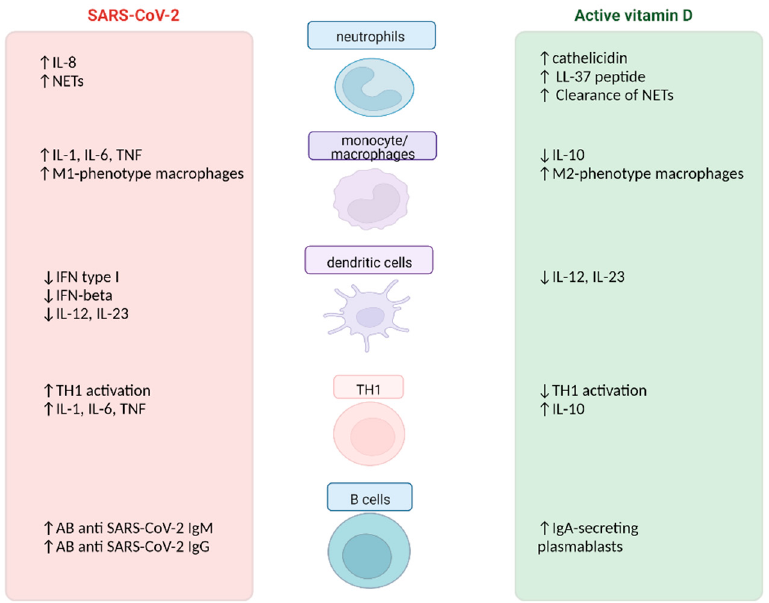
Figure 1. Main biological effects of SARS-CoV-2 and active vitamin D on immune cells. Abbreviations: AB: antibodies, Ig: immunoglobulin; IFN: interferon; IL: interleukin; TH: T helper; TNF: tumor necrosis factor; M1: classically activated macrophages; M2: alternatively activated macrophages; NETs: neutrophil extracellular traps. Symbols: ↑ : upregulation; ↓ : downregulation. Produced at www.biorender.com (accessed on 11 November 2022).